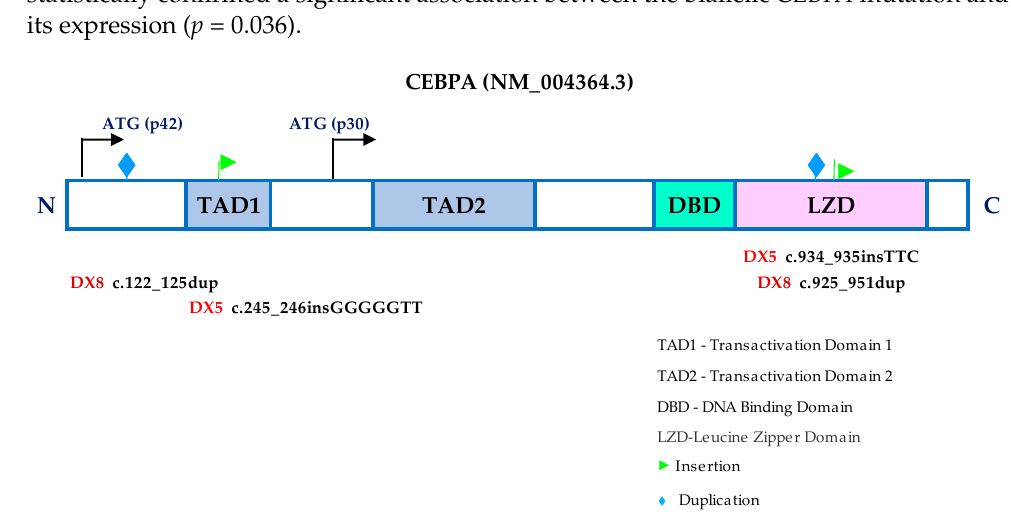
Figure 5. A schematic representation of the CEPBA gene structure with two alternative start sites that give rise to different isoforms (p42 and p30). Patients DX5 and DX8 had biallelic frameshift mutations at the N-terminal region and in-frame insertion at the C-terminal bZIP mutations.